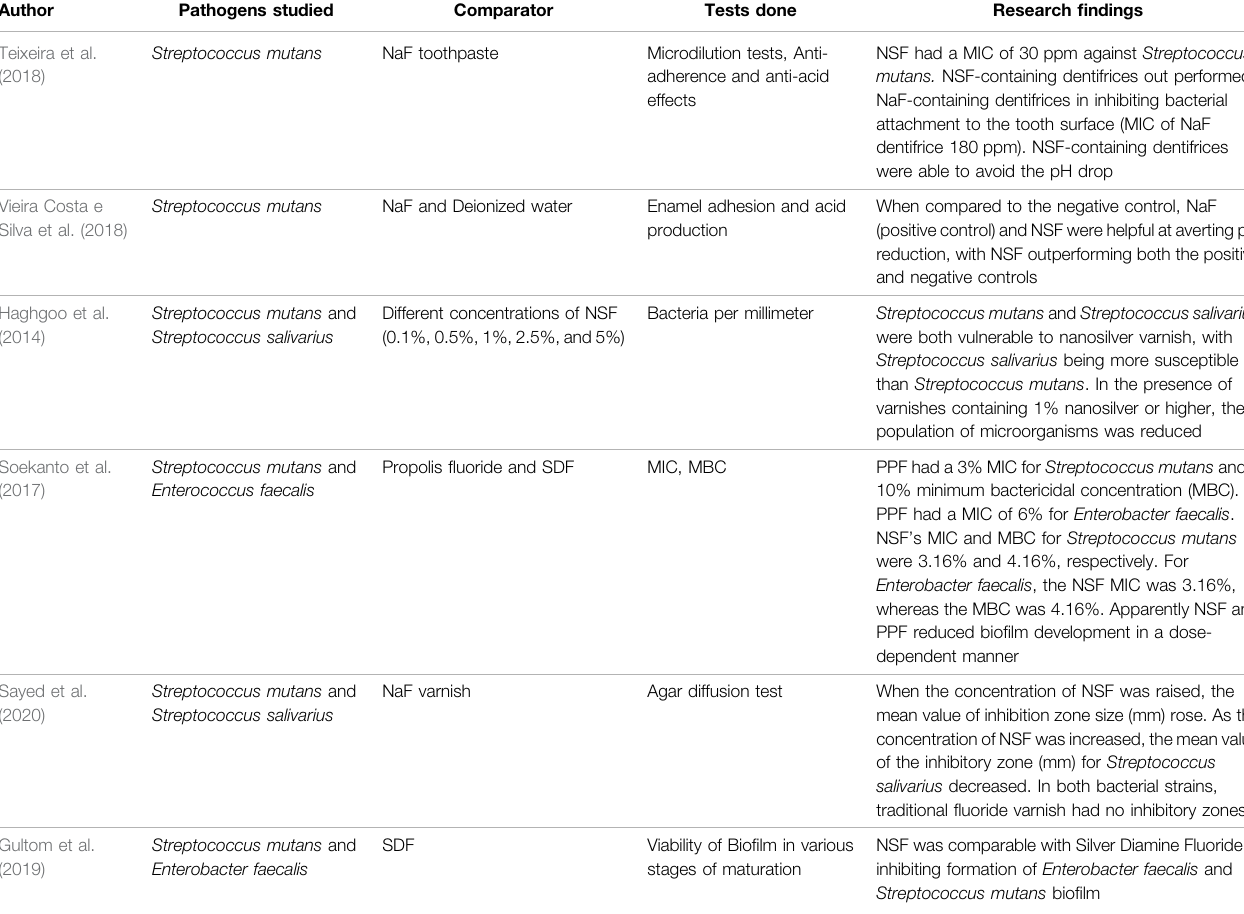
TABLE 1 | Studies related to anti-microbial activity of NSF against cariogenic